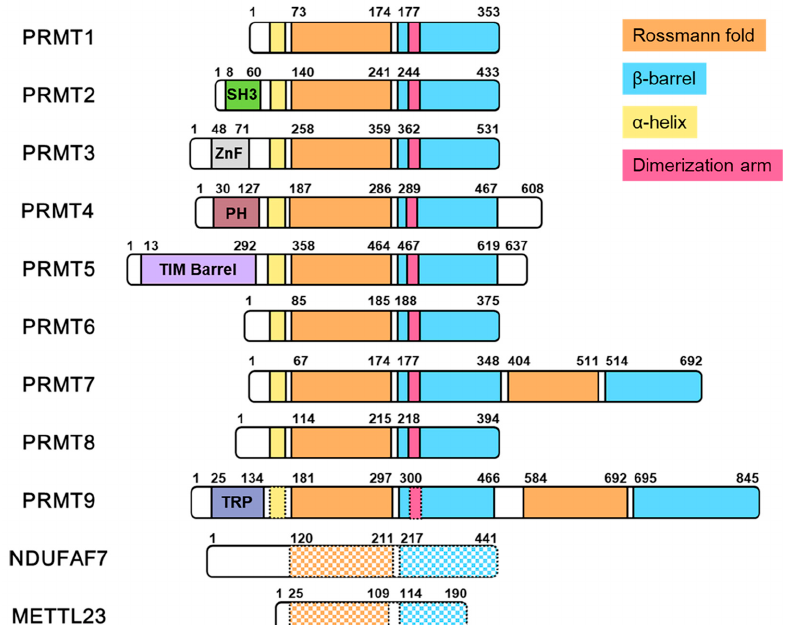
Figure 2. Protein arginine methyltransferases and novel members. For all proteins, the residue numbers are based on human protein sequences. Domains are assigned based on protein alignments within PRMT family members and the examination of the crystal structure data when available. The second Rossmann fold and β -barrel domain in the C-terminal region of PRMT7 is catalytically inactive. The domains of PRMT9 are assigned based on protein alignment alone since crystal structural data is unavailable. The dashed lined α -helix and dimerization arm region in PRMT9 indicates that this is expected, but there is a lack of crystal structure data to confirm this. The dashed, checkerboard pattern in the domains of NDUFAF7 and METTL23 indicates that there is limited protein sequence similarity when compared with the Rossmann fold and β -barrel domains of the PRMTs by sequence alignment. The protein sequences can be found in UniProt: PRMT1, Q99873-3;